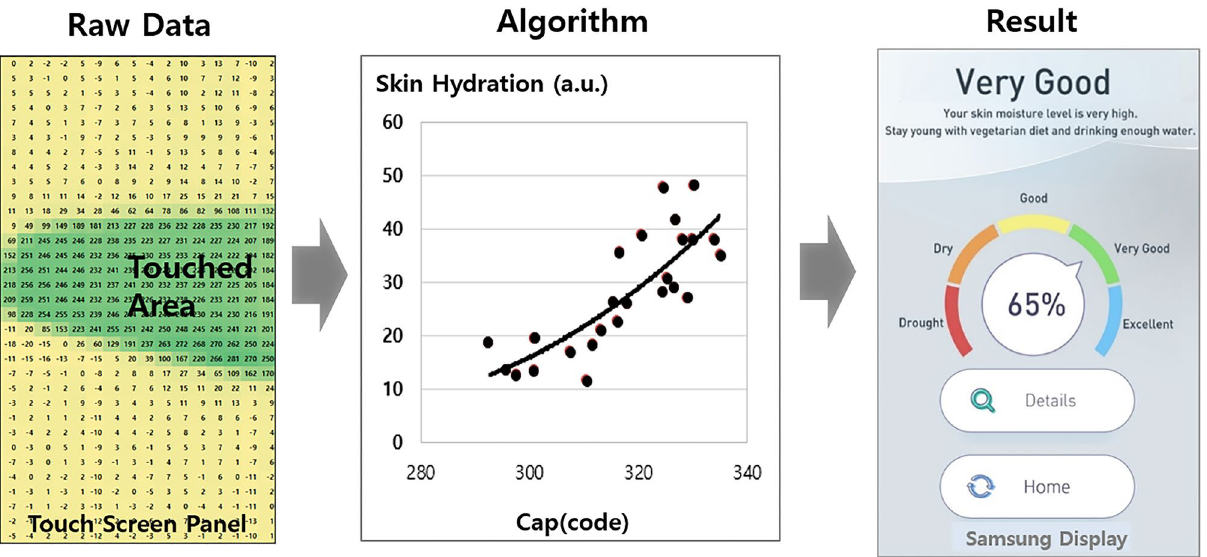
Figure 3. Data processing flow for skin hydration measurement using